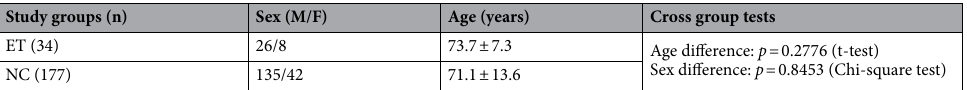
Table 1. Characteristics of the study groups (data are given as mean ± standard